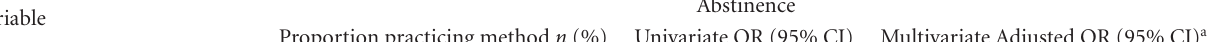
Table 2: Univariate and multivariate analysis of demographic and clinical characteristics associated with